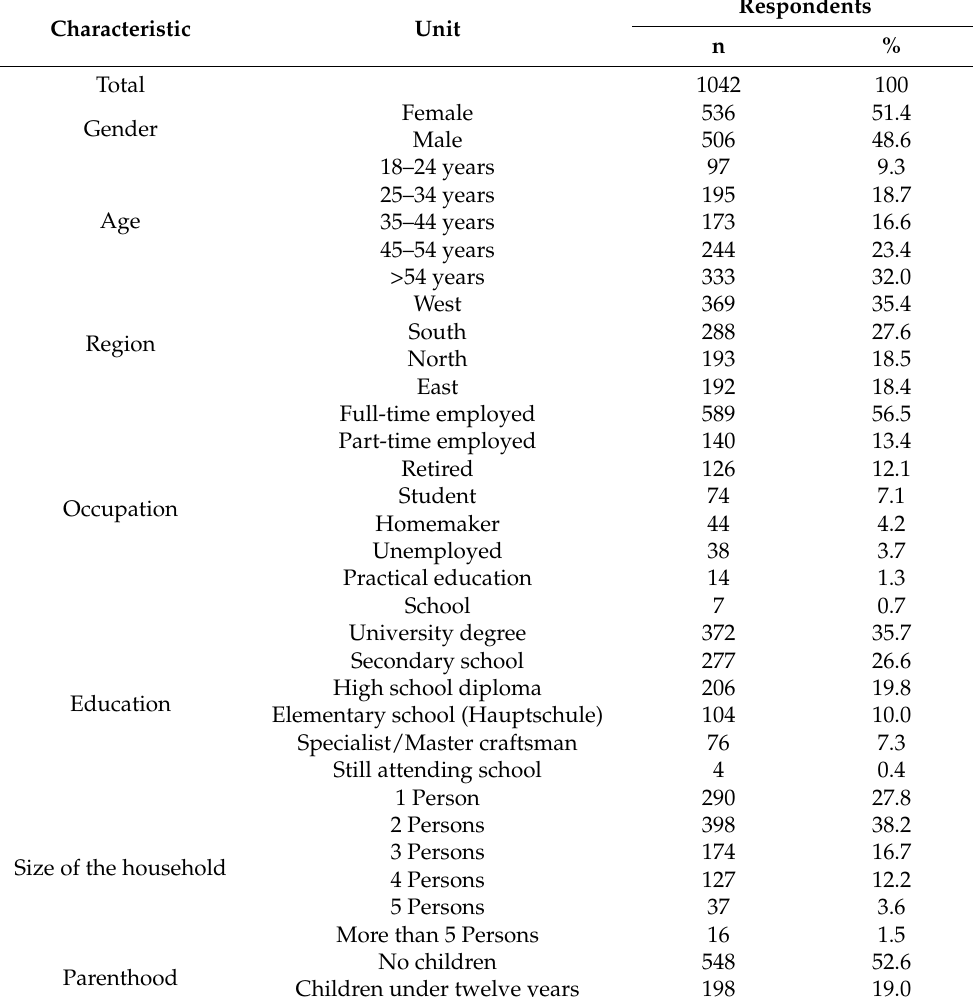
Table 2. Characteristics of survey participants and social-demographic